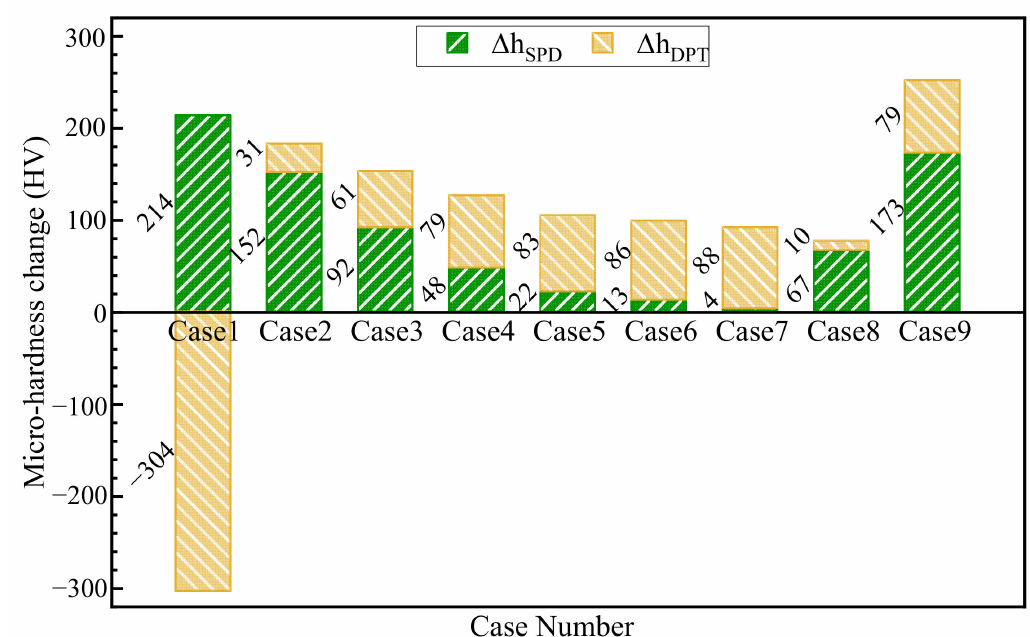
Figure 11. Predicted values of surface microhardness change.